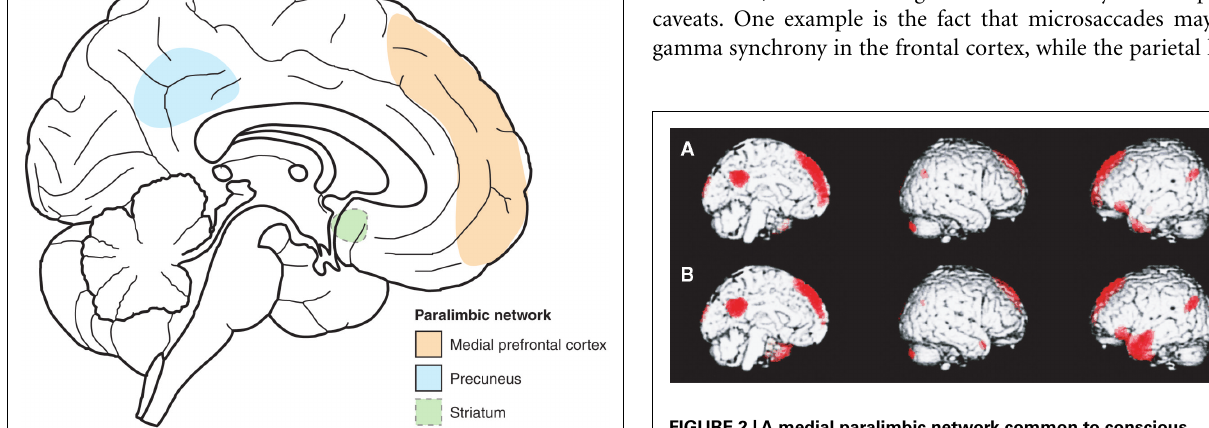
FIGURE 2 |A medial paralimbic network common to conscious experiences. The figure shows brain maps of activity related to self and other (midline, right, and left hemisphere). (A) Emergence of self-representation. Differential activity is noted in medial paralimbic regions, together with bilateral occipital and parietal regions ( p < 0.05, corrected for multiple comparisons). (B) Emergence of representation of other (Danish Queen). Differential activity is noted in medial paralimbic regions, together with bilateral occipital and parietal regions and a confluent left inferior prefrontal and temporal region. Activity in the paralimbic network is similar across the two conditions, an indication of the pivotal role of this network in higher-order consciousness with self-reference. (Lou et al., 2004, with